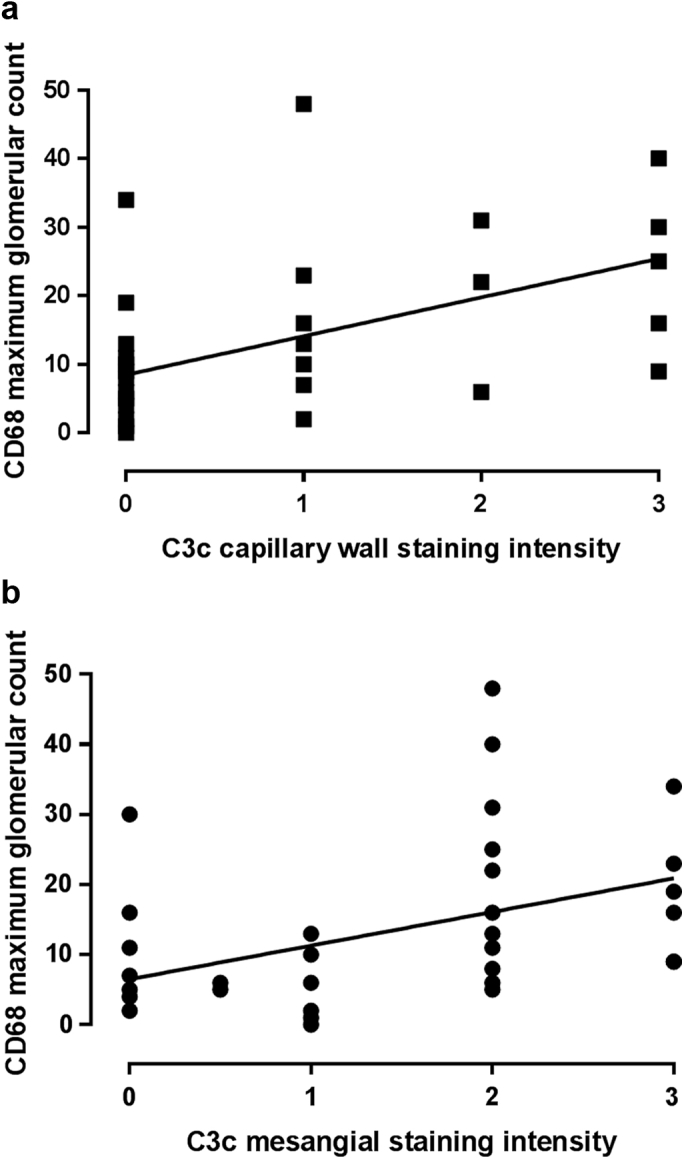
Correlation of glomerular complement C3c staining intensity and maximum glomerular CD68 count. C3c staining intensity in the (a) capillary wall and (b) mesangium correlated significantly with maximum glomerular CD68 count (r = 0.57, P = 0.0003 and r = 0.51, P = 0.002, respectively).